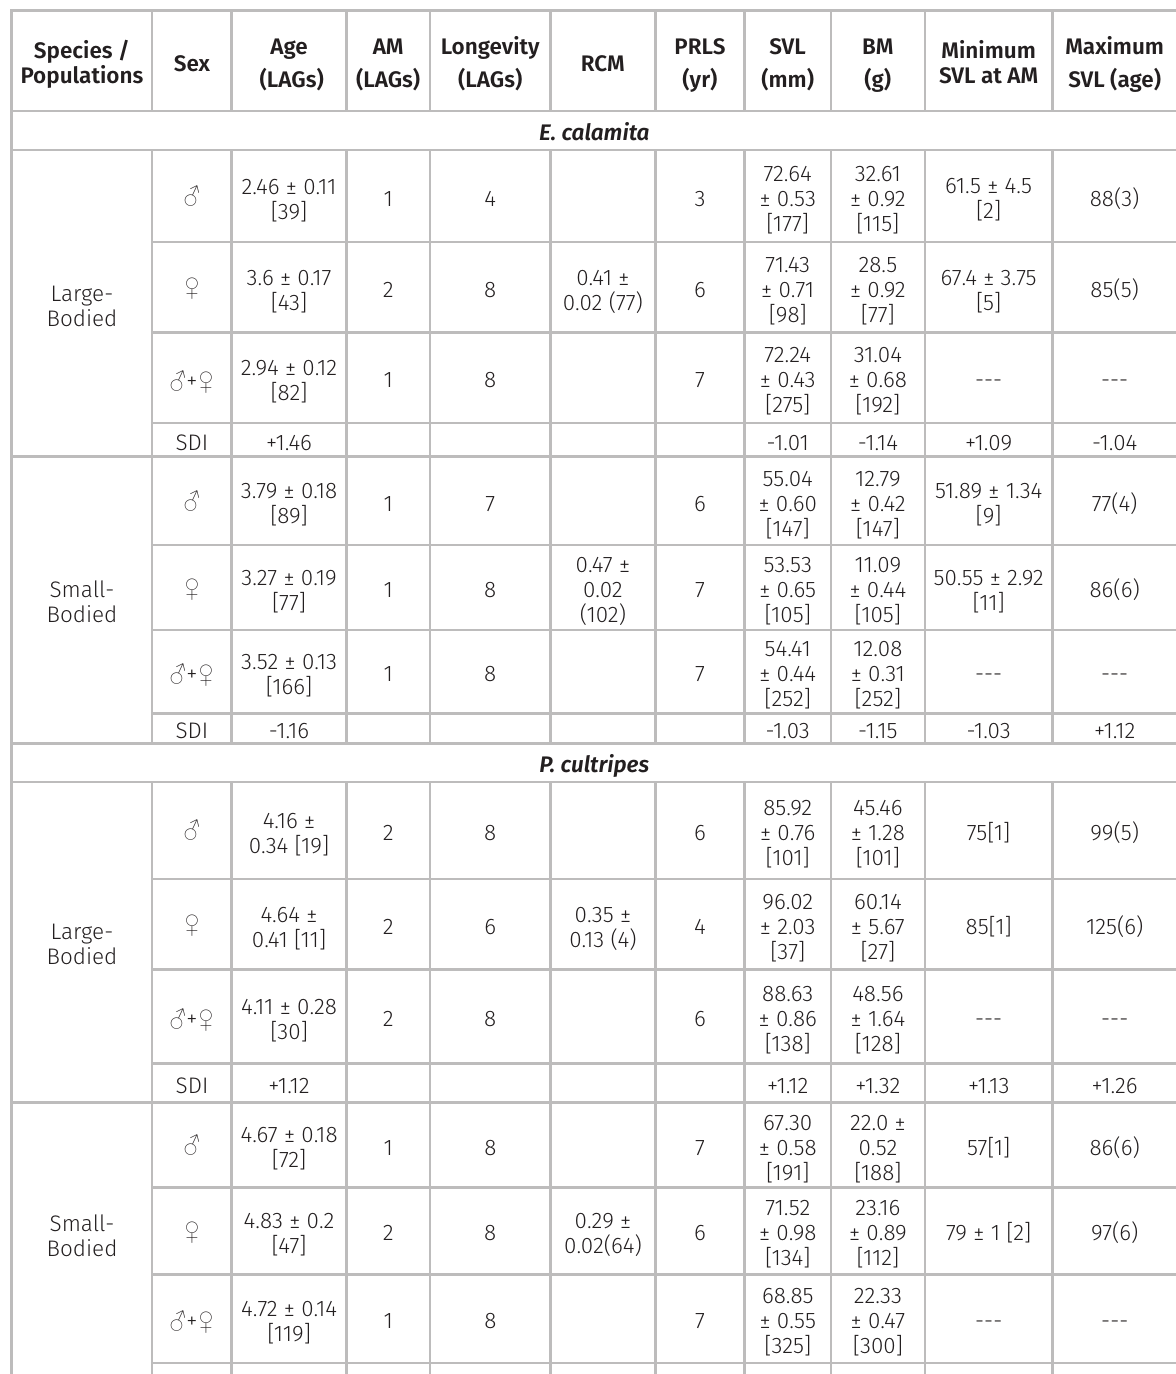
Table I. Age and size-related parameters of Small (Sandy substrate) and Large-Bodied populations (Hercinic substrate) of Epidalea calamita and Pelobates cultripes . AM = age at sexual maturity of the youngest first breeders; PRLS = potential reproductive lifespan, computed as the difference between longevity and AM; SVL = snout-vent length (mm), BM: body mass (g). SDI: sexual dimorphism index. All values for Age, SVL, BM and Minimum SVL at AM are expressed as mean ± 1 SE, [n]: sample